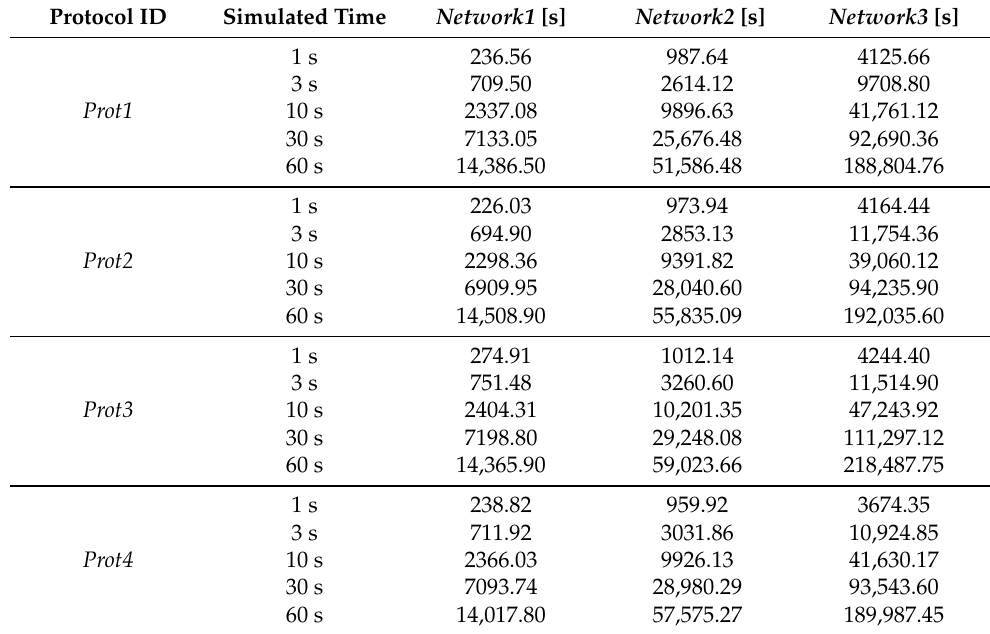
Table 5. Processing time for the serial